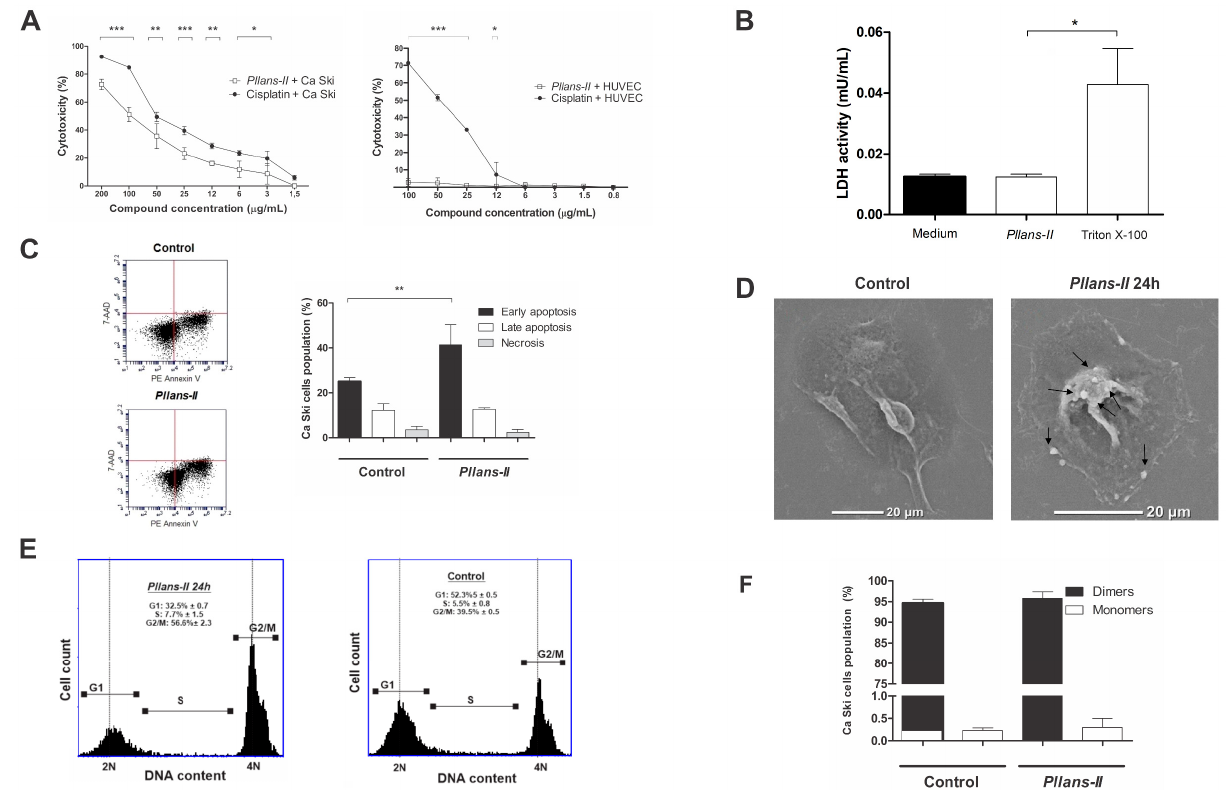
Figure 1. Pllans–II induces apoptotic death and cell cycle arrest in Ca Ski. ( A ) Cytotoxic activity of Pllans–II and Cisplatin ® on squamous epithelial cells of cervical cancer and non–tumorigenic cells; Ca Ski cells and non–tumorigenic line of human endothelial cells (HUVEC) were treated with concentrations of serial dilutions (200–1.5 µ g/mL) of both Pllans–II and Cisplatin ® . ( B ) Effects of Pllans–II (100 µ g/mL) on lactate dehydrogenase (LDH) levels in Ca Ski cell medium after 24 h of treatment. Data are expressed as mean ± SD, and procedures were carried out in triplicate. ( C ) Flow cytometry analysis of cell death generated in Ca Ski cells by Pllans–II treatment (100 µ g/mL). The dot plot revealed the percentage of cells in early apoptosis (lower right quadrant), late apoptosis (upper right quadrant), and necrosis (upper left quadrant). The bar chart shows the percentages of cells at each stage. ( D ) Morphological changes induced by Pllans–II (100 µ g/mL) on Ca Ski cells, detected by